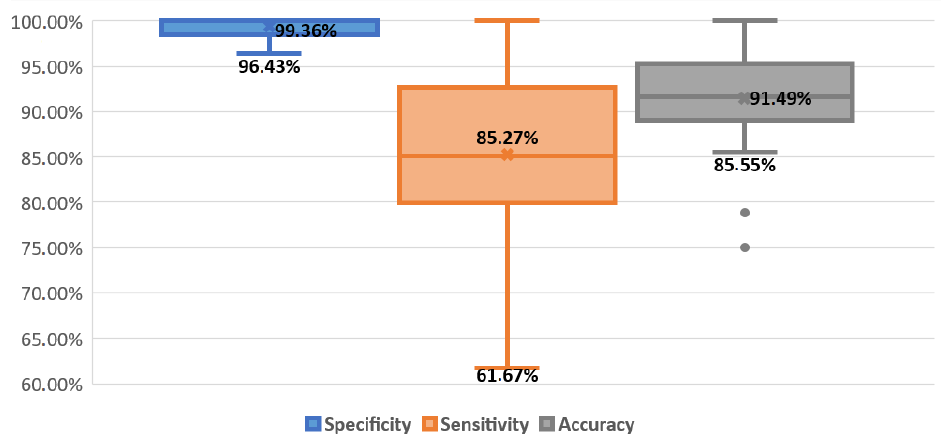
Figure 12. Box plot for final respiratory detection result. The line and the cross inside the box correspond to the median and the mean value, respectively. The box-limits represent the first and the third quartiles, the points highlight outliers, and the upper and lower bars represent the maximum and minimum values, respectively. Specificity: blue box. Sensitivity: orange box. Accuracy: gray box.